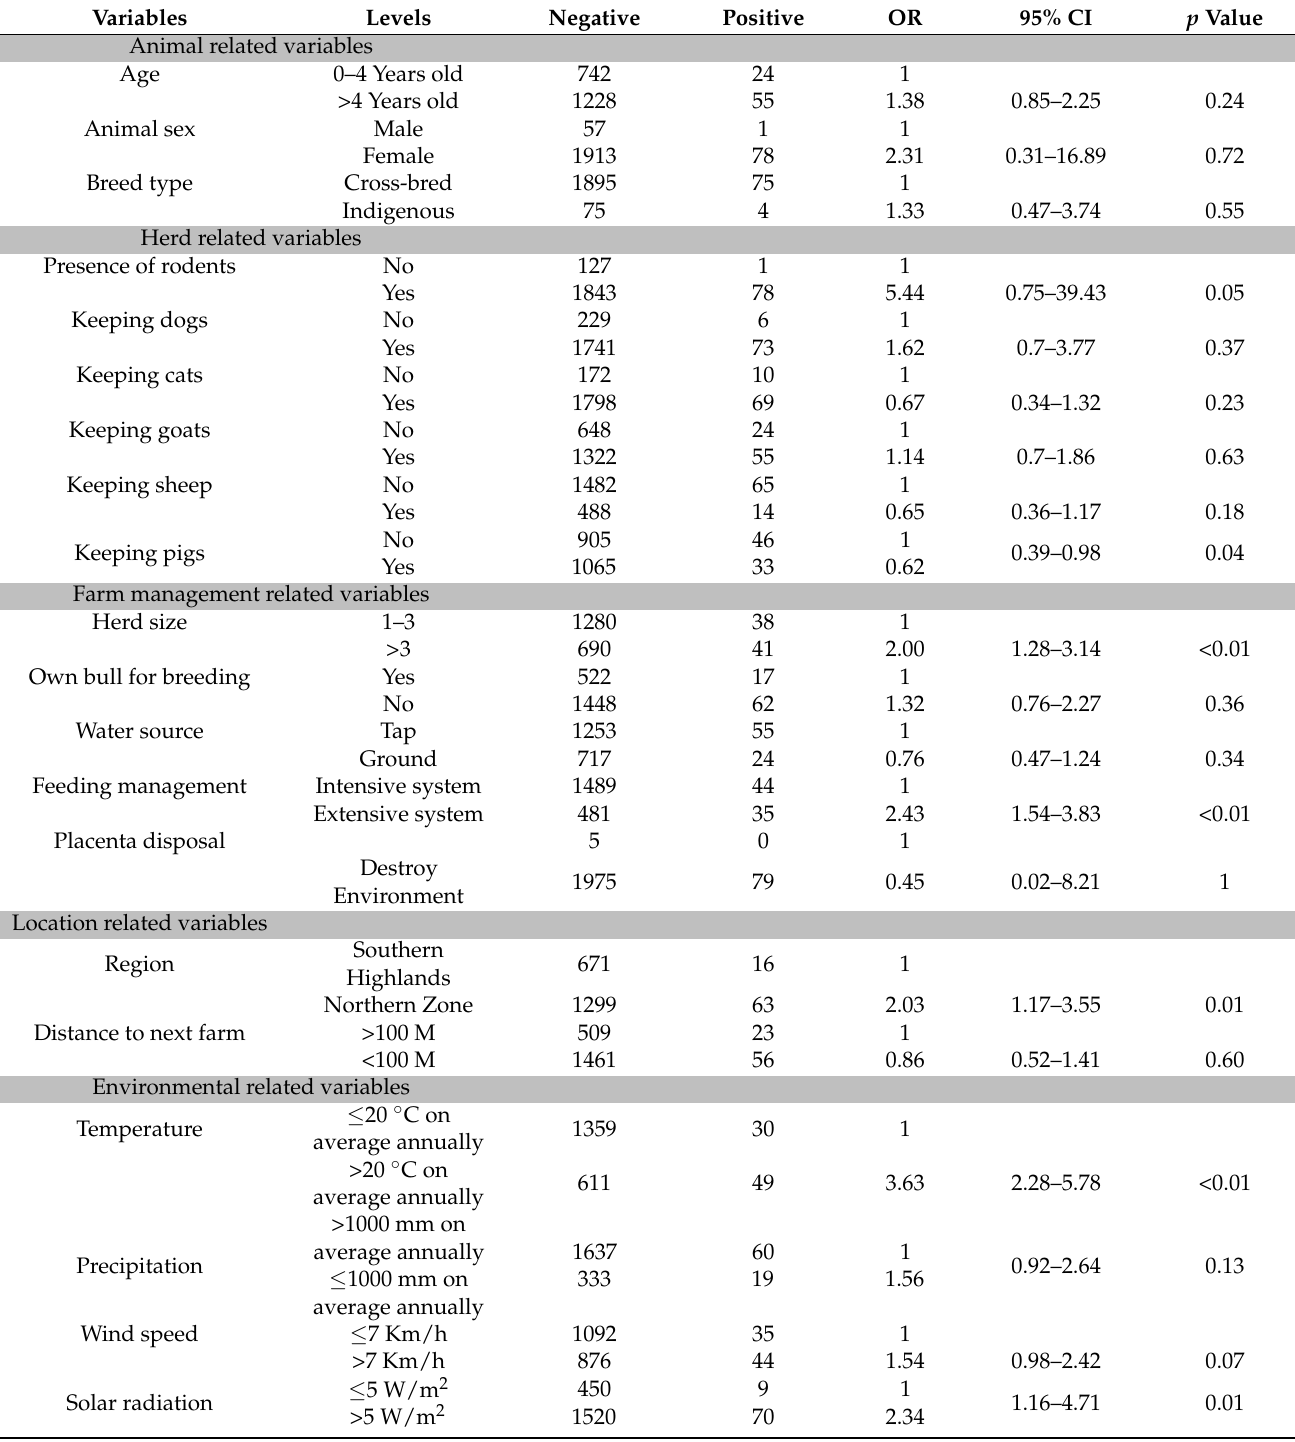
Table 2. Summary of univariable analysis results based on variables grouped into five categories in the background color (Animal, Herd, Farm management, location, and Environmental related variables). For each category the variables, levels, number of seronegative (Negative) and seropositive (Positive) animals, odds ratios (OR) with 95% confidence interval (95% CI) and significance test p - values ( p -value) are